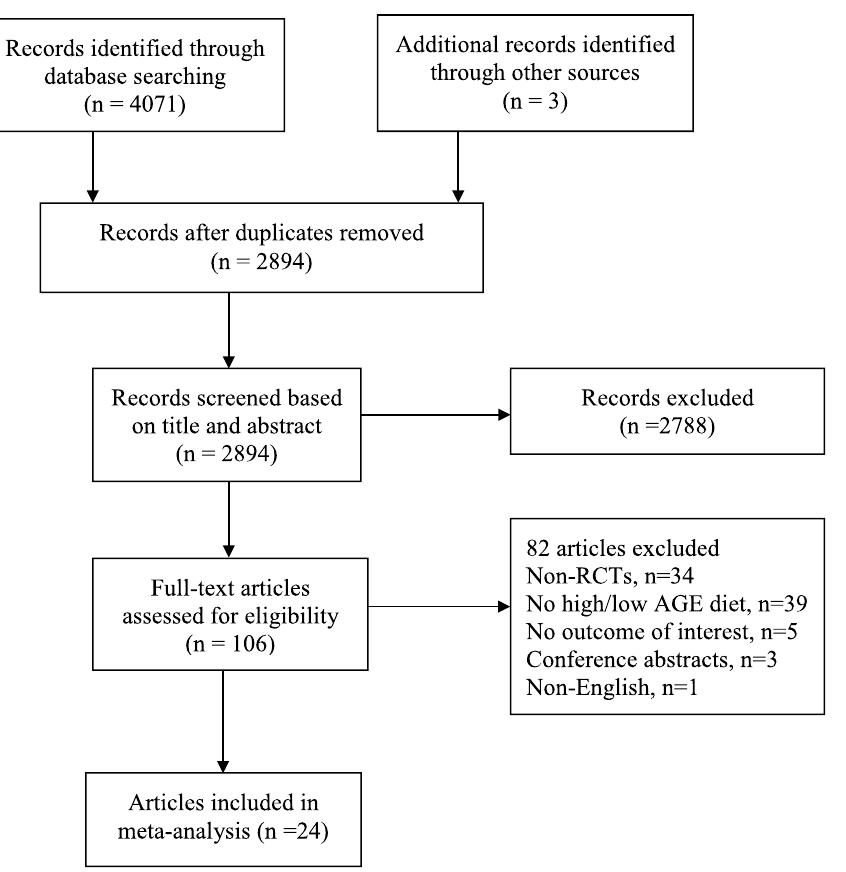
Figure 1. Flow chart of the process of study selection: schematic diagram shows the study selection